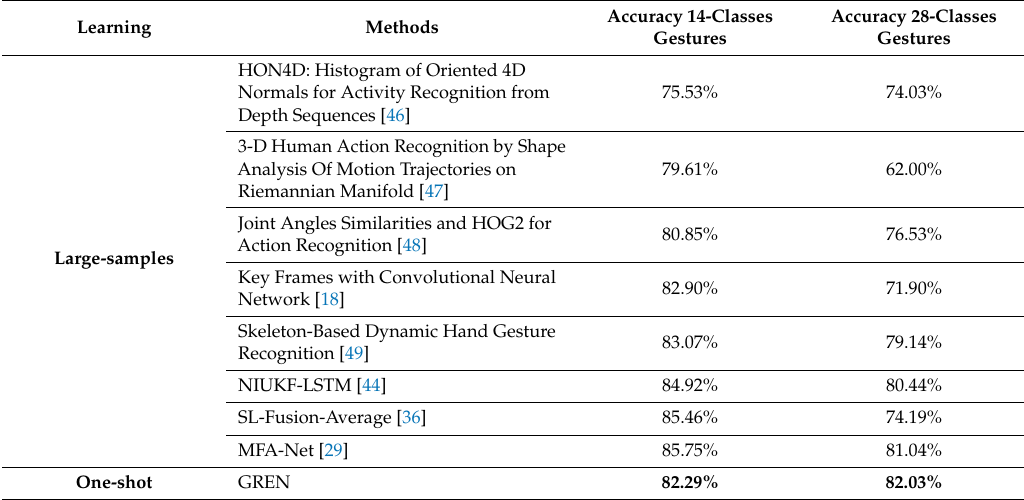
Table 3. Result of di ff erent method comparison for 14 / 28-classes gestures on dynamic hand gesture dataset using skeleton-based data.